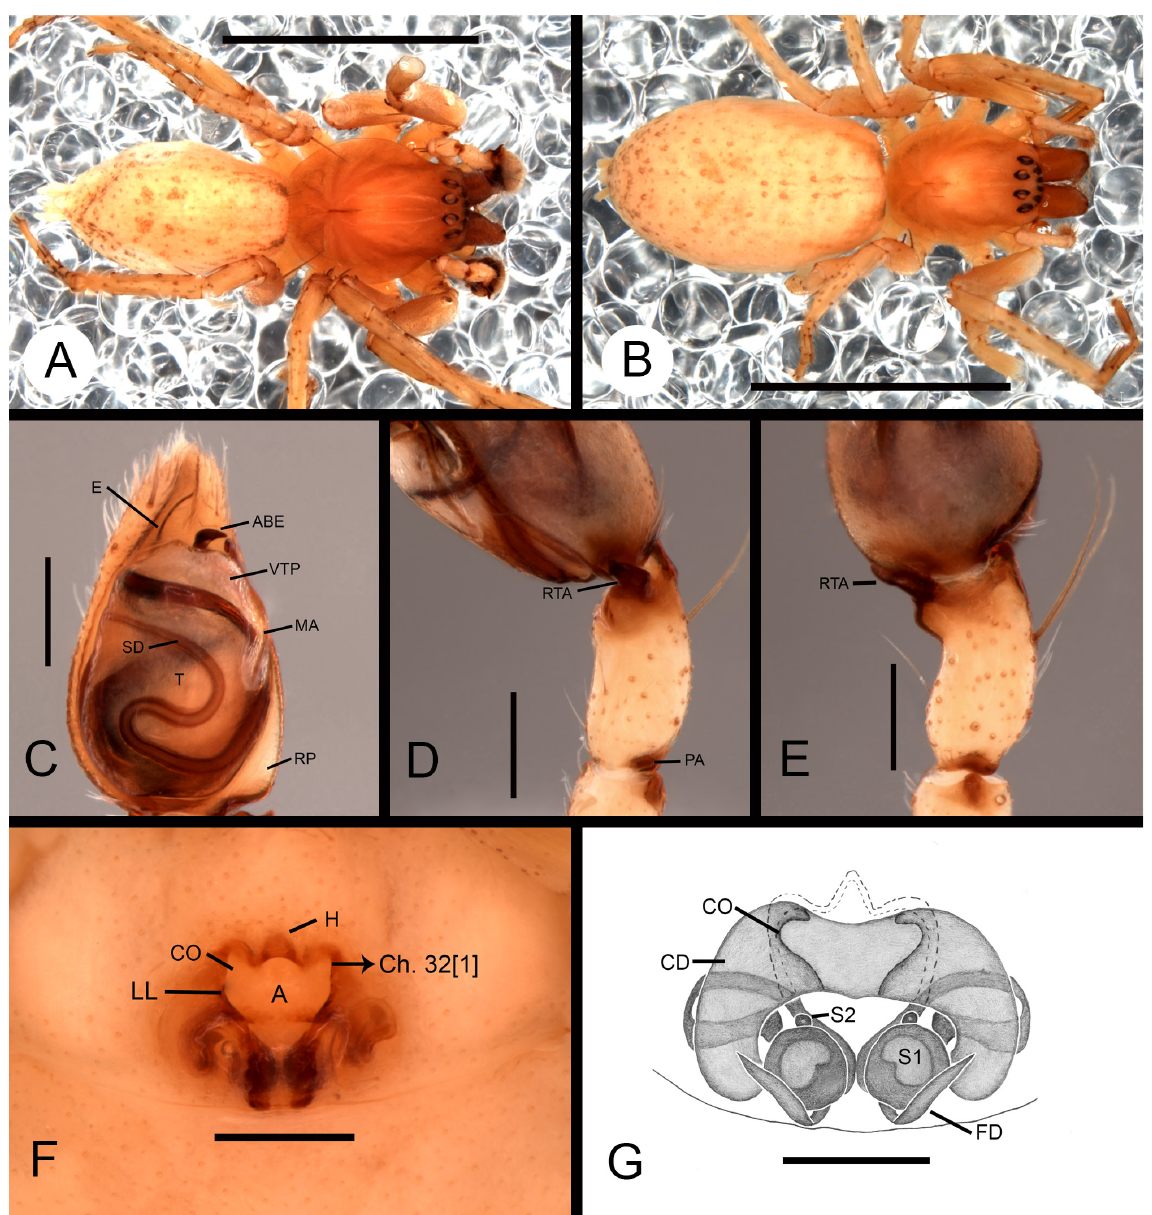
Fig. 22. Tafana silhavyi (Caporiacco, 1955) (A, C–E = ♂, MNHN 11312; B, F–G = ♀, MNHN 11312). A . Habitus, dorsal view. B . Habitus, dorsal view. C . Left palp, ventral view. D . Left palp, retrolateral view. E . Left palp, dorsal view. F . Epigynum, ventral view (arrow indicating character). G . Vulva, dorsal view. Abbreviations: A = atrium; ABE = apophysis of base of the embolus; CD = copulatory ducts; CO = copulatory opening; Ch = character; E = embolus; FD = fertilization ducts; H = hood; LL = lateral lobes; MA = median apophysis; PA = patellar apophysis; RP = retrolateral projection; RTA = retrolateral tibial apophysis; S1 = primary spermathecae; S2 = secondary spermathecae; SD = sperm duct; T = tegulum; VTP = ventral tegular process. Scale bars: A–B = 2.16 mm; C–G = 0.25